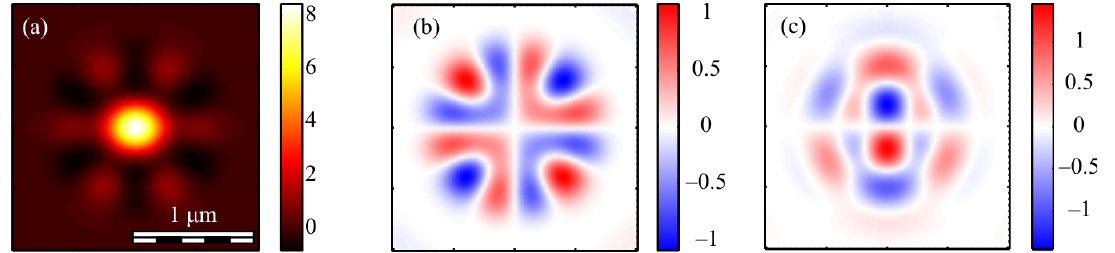
Figure 10. The Stokes vector components s 1 ( a ), s 2 ( b ), and s 3 ( c ) of the focused vector field (1) with m = 3 and a = 1.